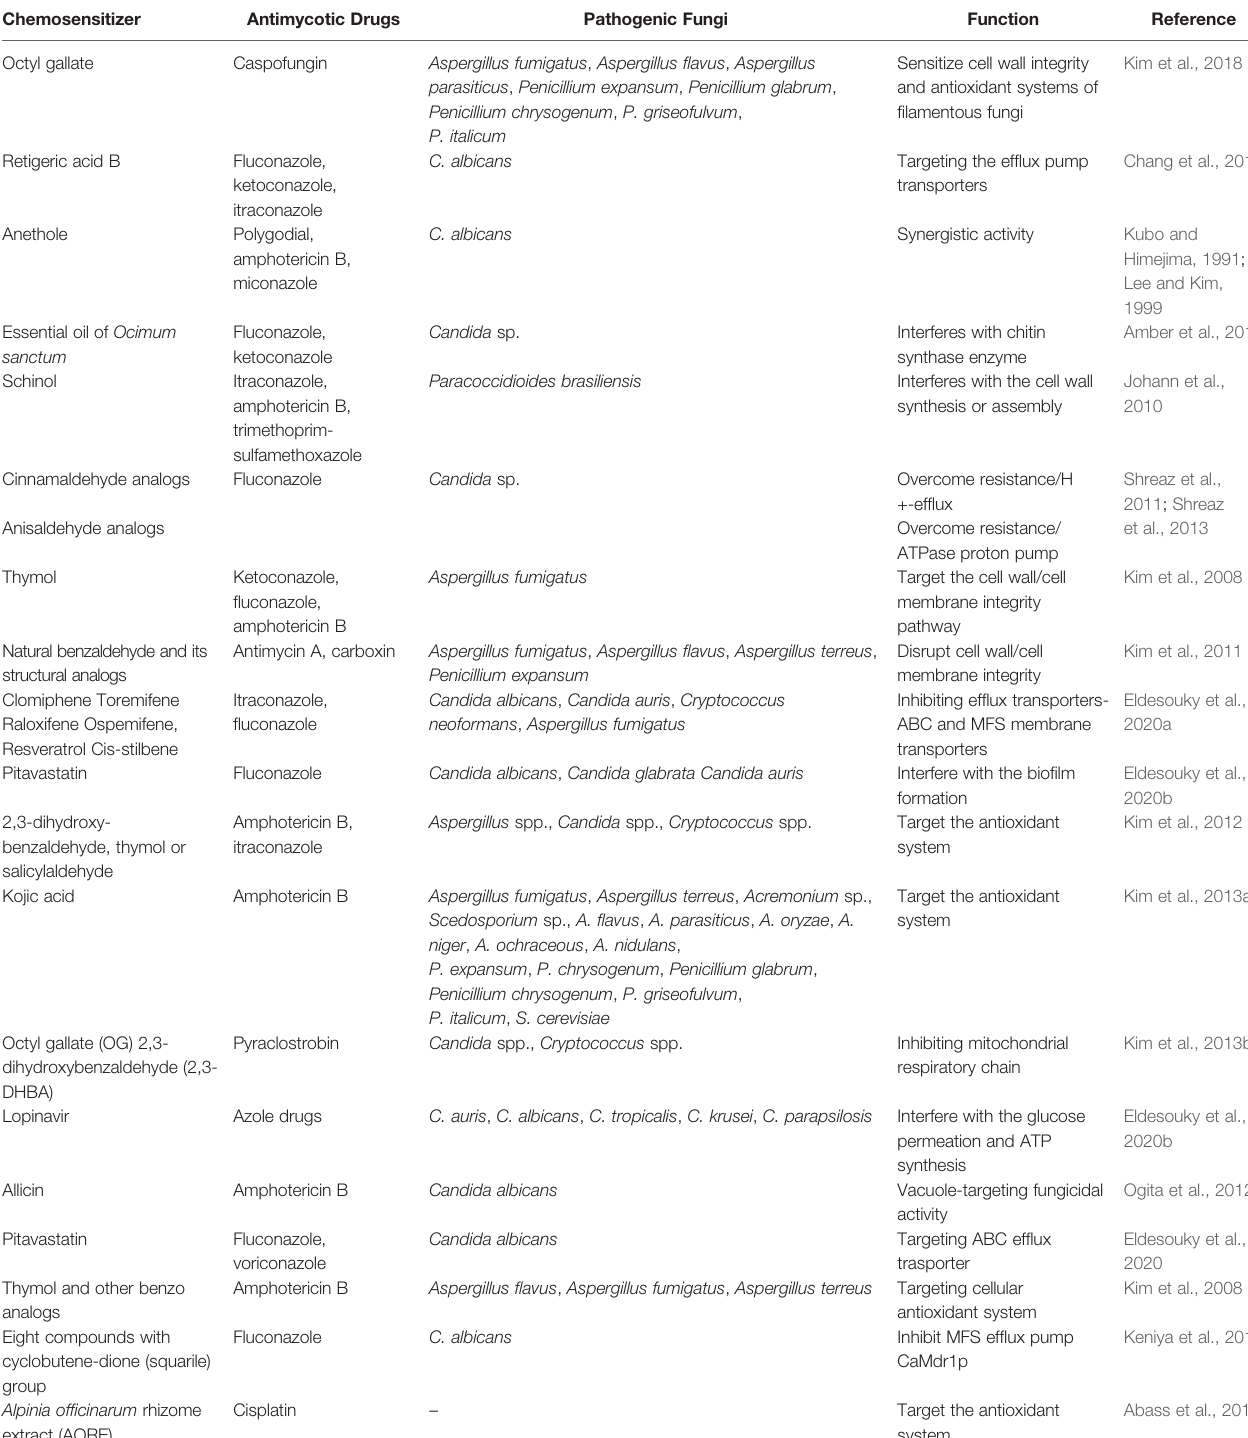
TABLE 1 | Natural chemosensitizer along with the commercial antimycotic drugs to augment fungicidal activity against human